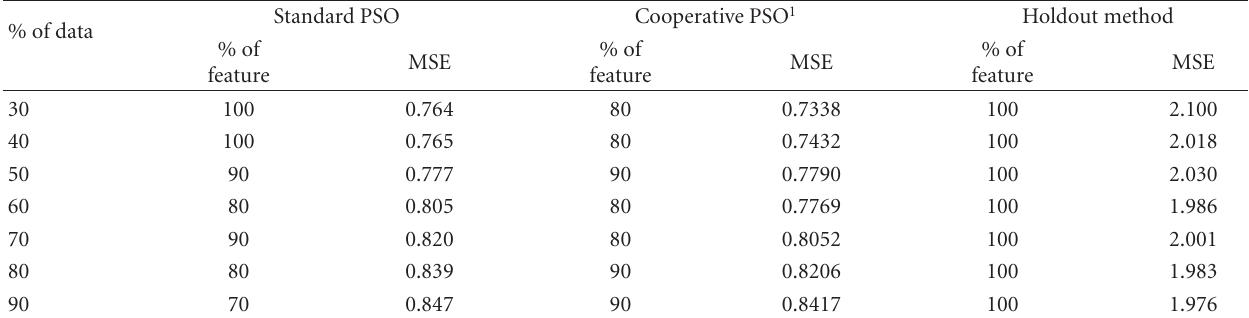
Table 15: The comparison of RMSE obtained when using standard PSO, CPSO, and standard fuzzy model with holdout method for PM10 data with C =